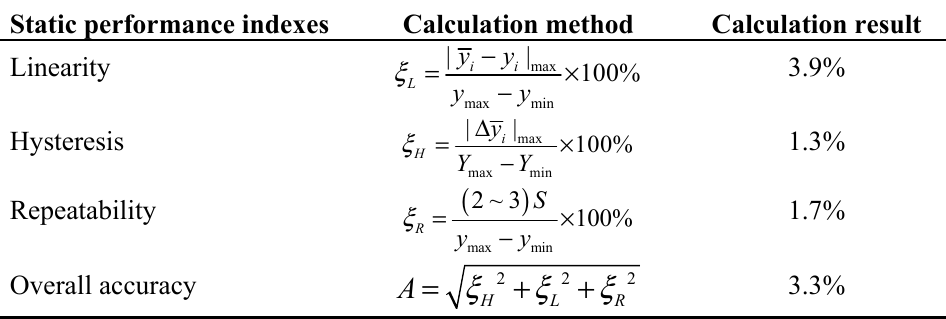
Table 1. Static performance indexes of the smart steel strand.